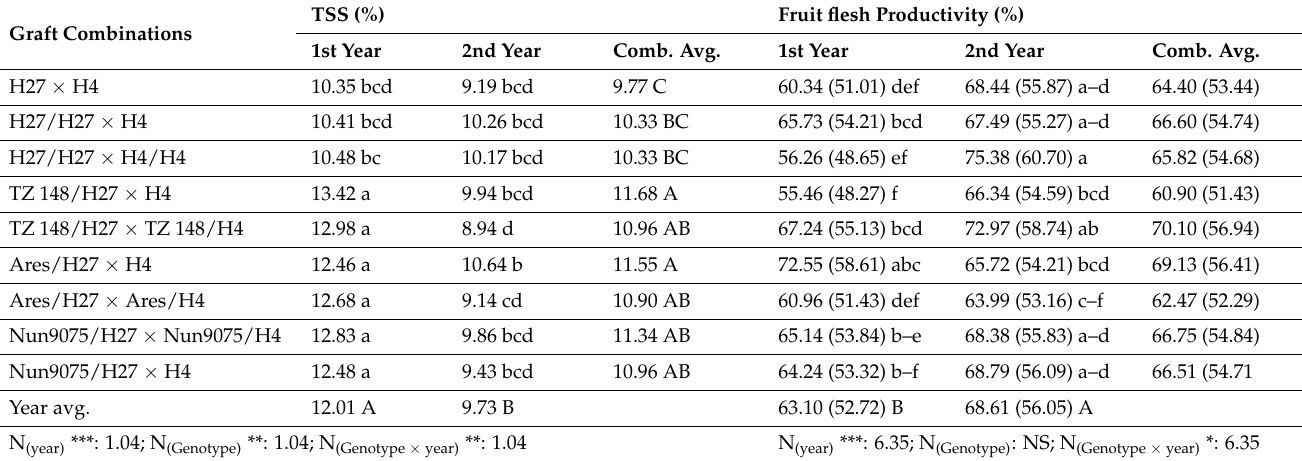
Table 6. The TSS and fruit flesh productivity of different graft combinations in both